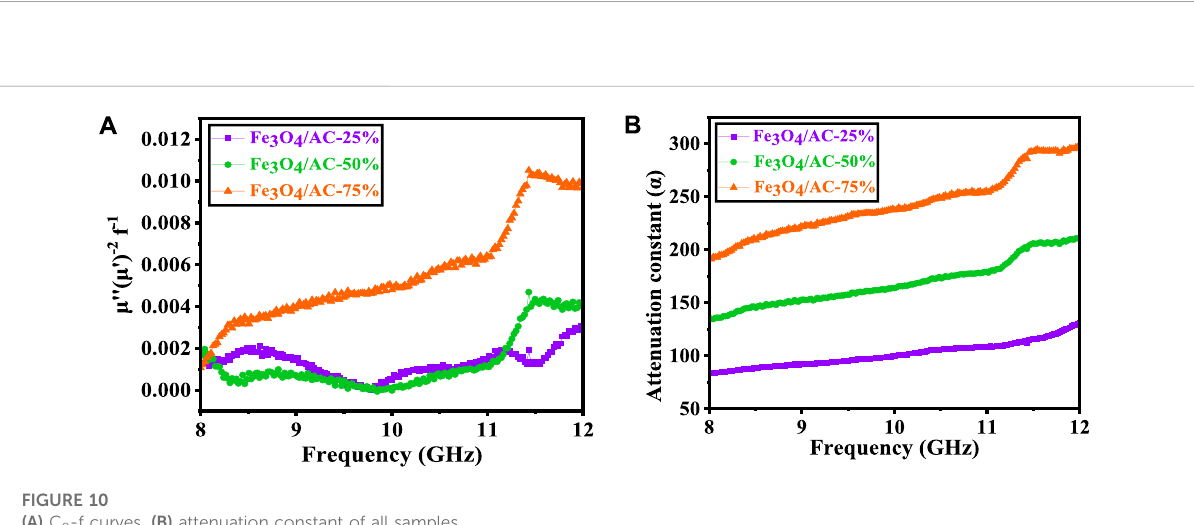
FIGURE 10 (A) C 0 -f curves, (B) attenuation constant of all